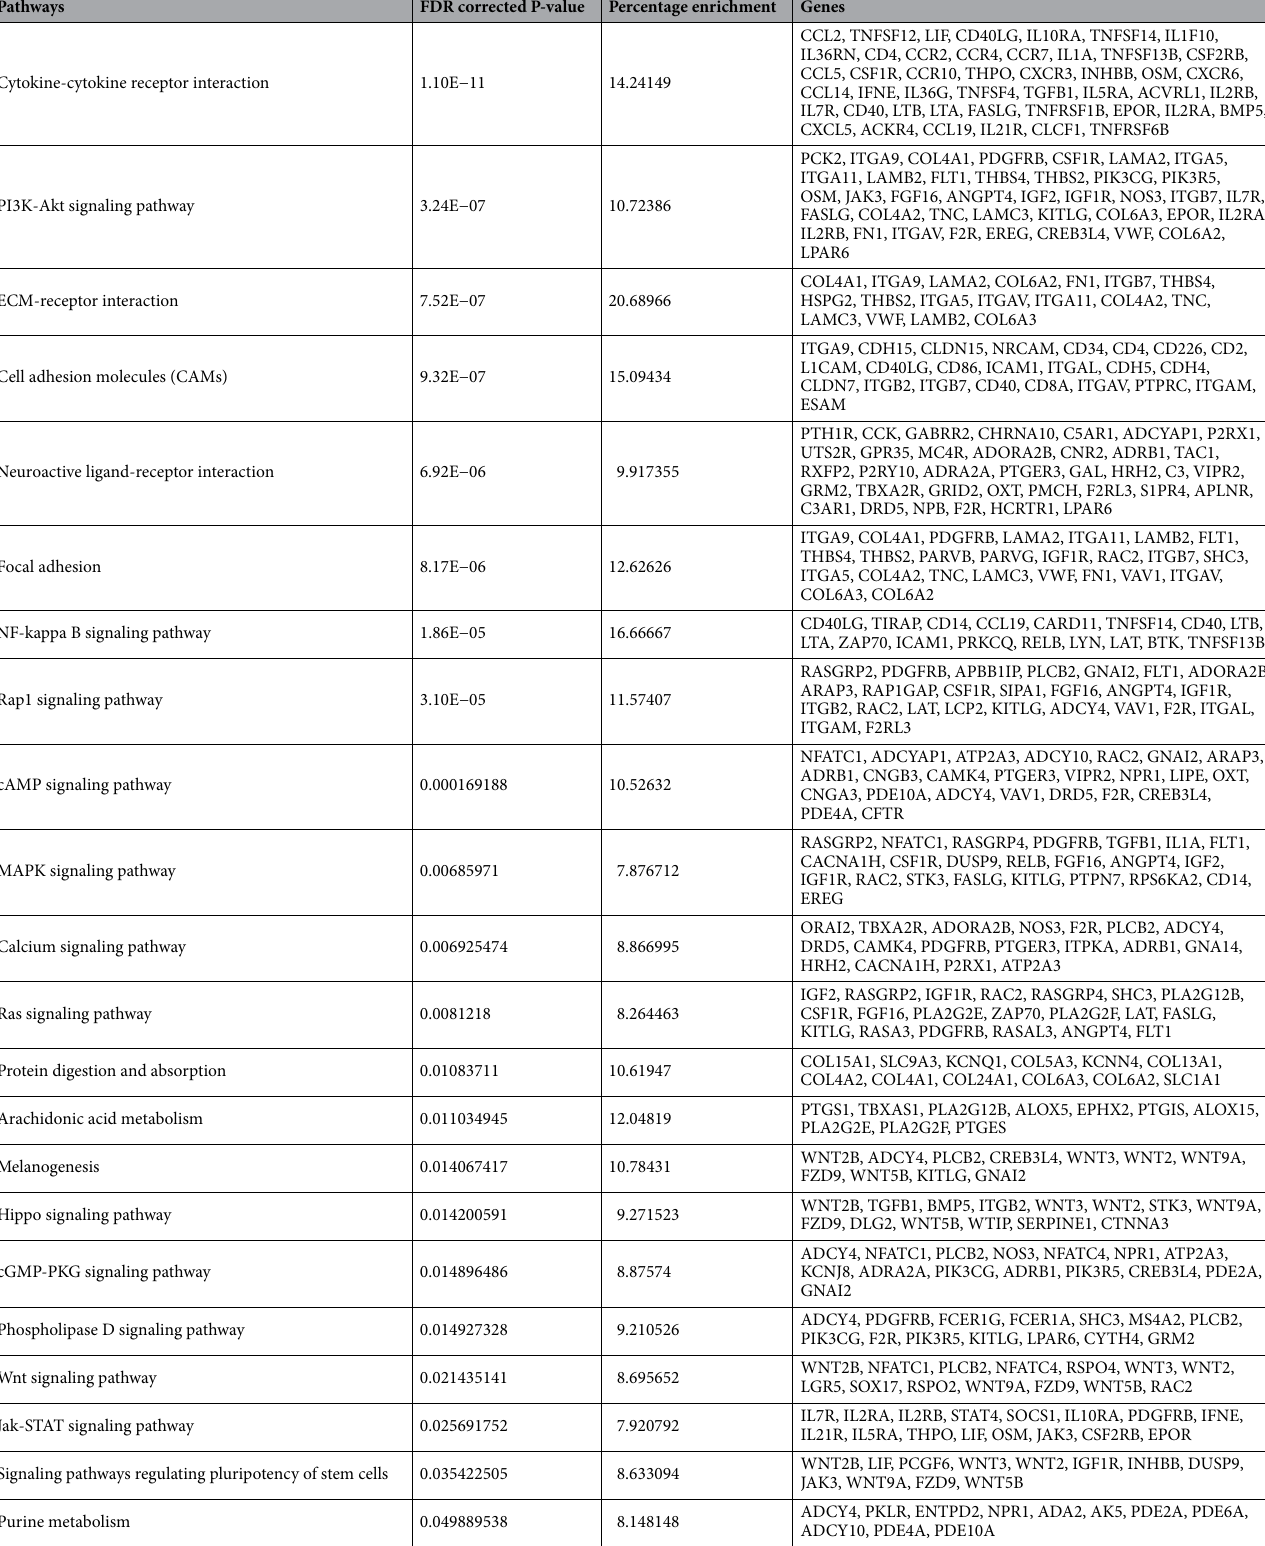
Table 1. Enriched KEGG pathways for DEGs between anagen and